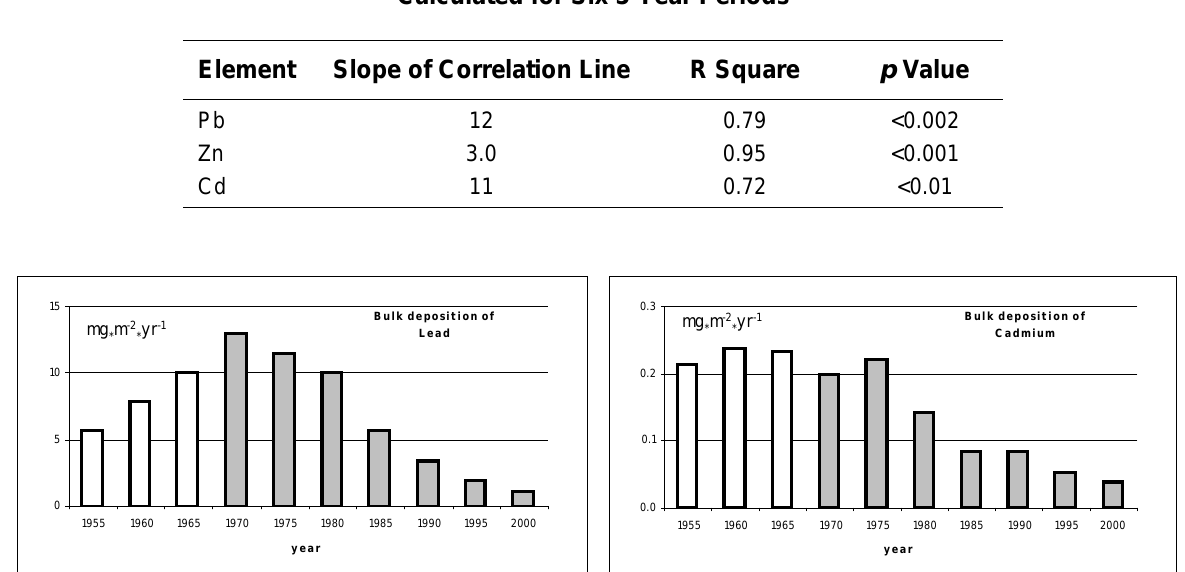
FIGURE 4. Estimated and measured bulk deposition of Pb and